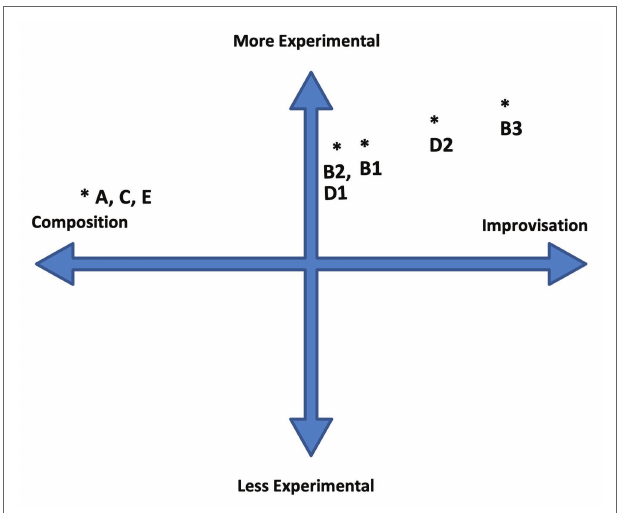
FIGURE 3 | ECIC interactions in “Spiral Staircase.” The asterisk indicates the position of events: A, and/or B, and/or C, and /or B1,